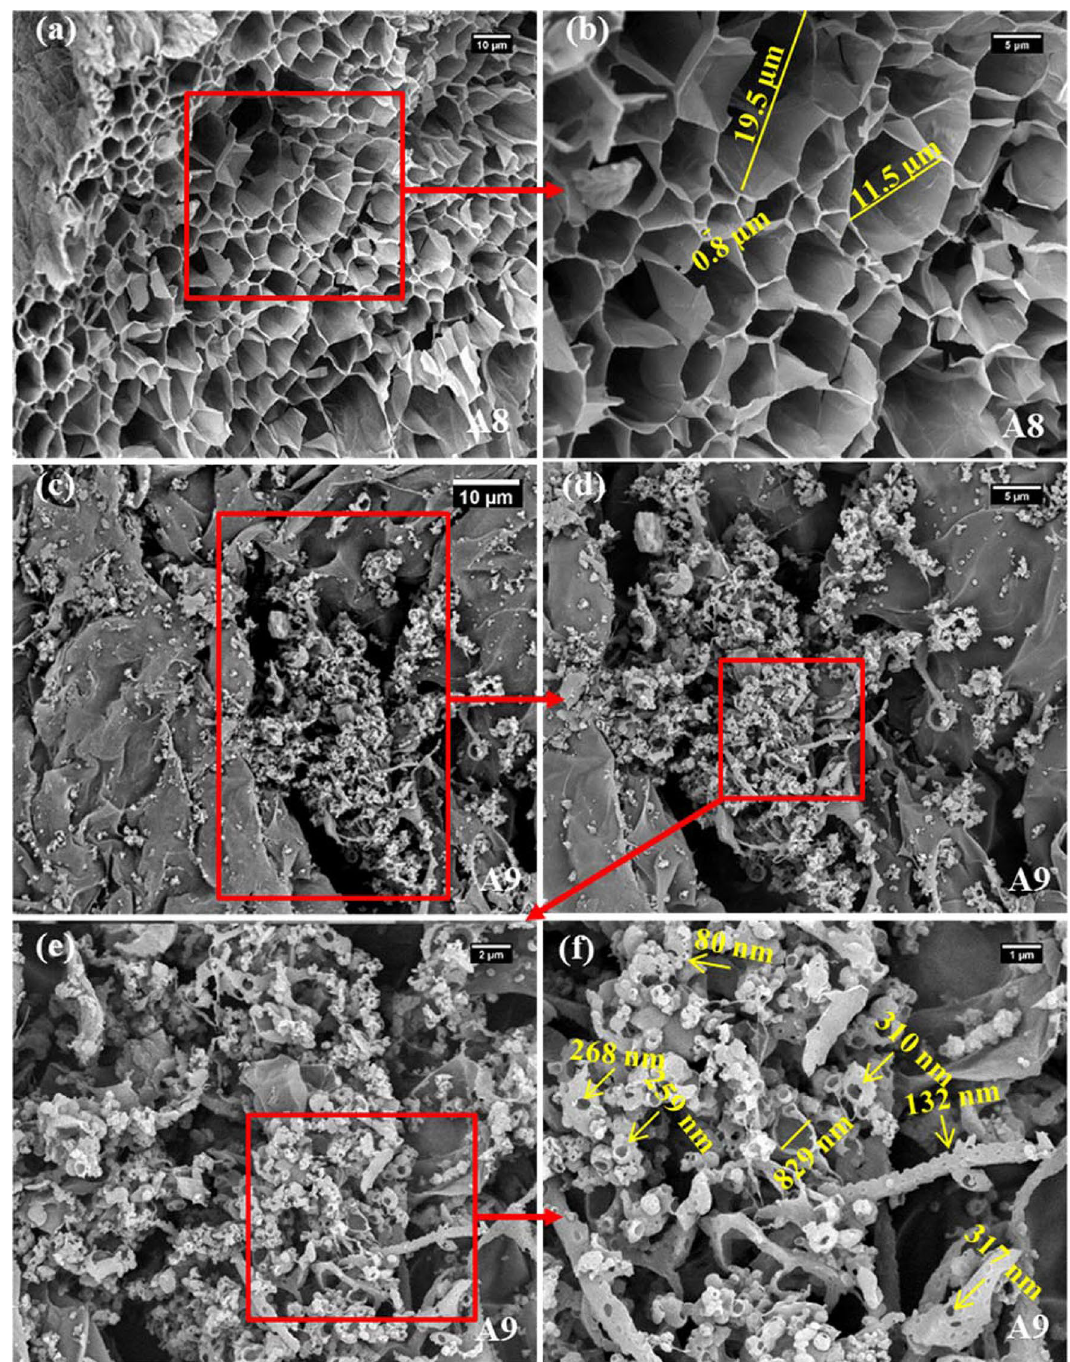
Figure 3. SEM images of selected SA-based hydrogels ( a , b ) A8, and ( c – f ) A9